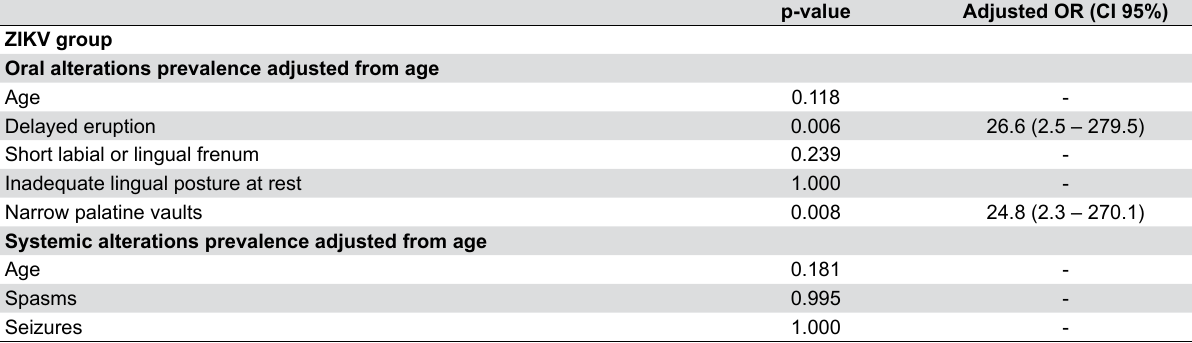
CARVALHO IF, ALENCAR PNB, CARVALHO de ANDRADE MD, SILVA PGB, CARVALHO EDF, ARAÚJO LS, CAVALCANTE MPM, SOUSA Table 4- Multivariate analysis evaluating the influence of age on the prevalence of oral and systemic alterations in infants with ZIKV